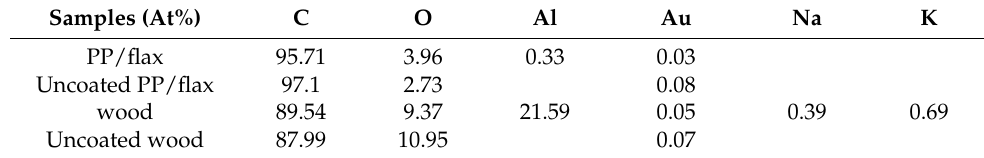
Figure 10. Surface morphology of the char produced after flame test. ( a ) coated wood, ( b ) uncoated wood ( c ), coated PP/flax and ( d ) uncoated PP/flax. Table 3. Elemental analysis after-burn